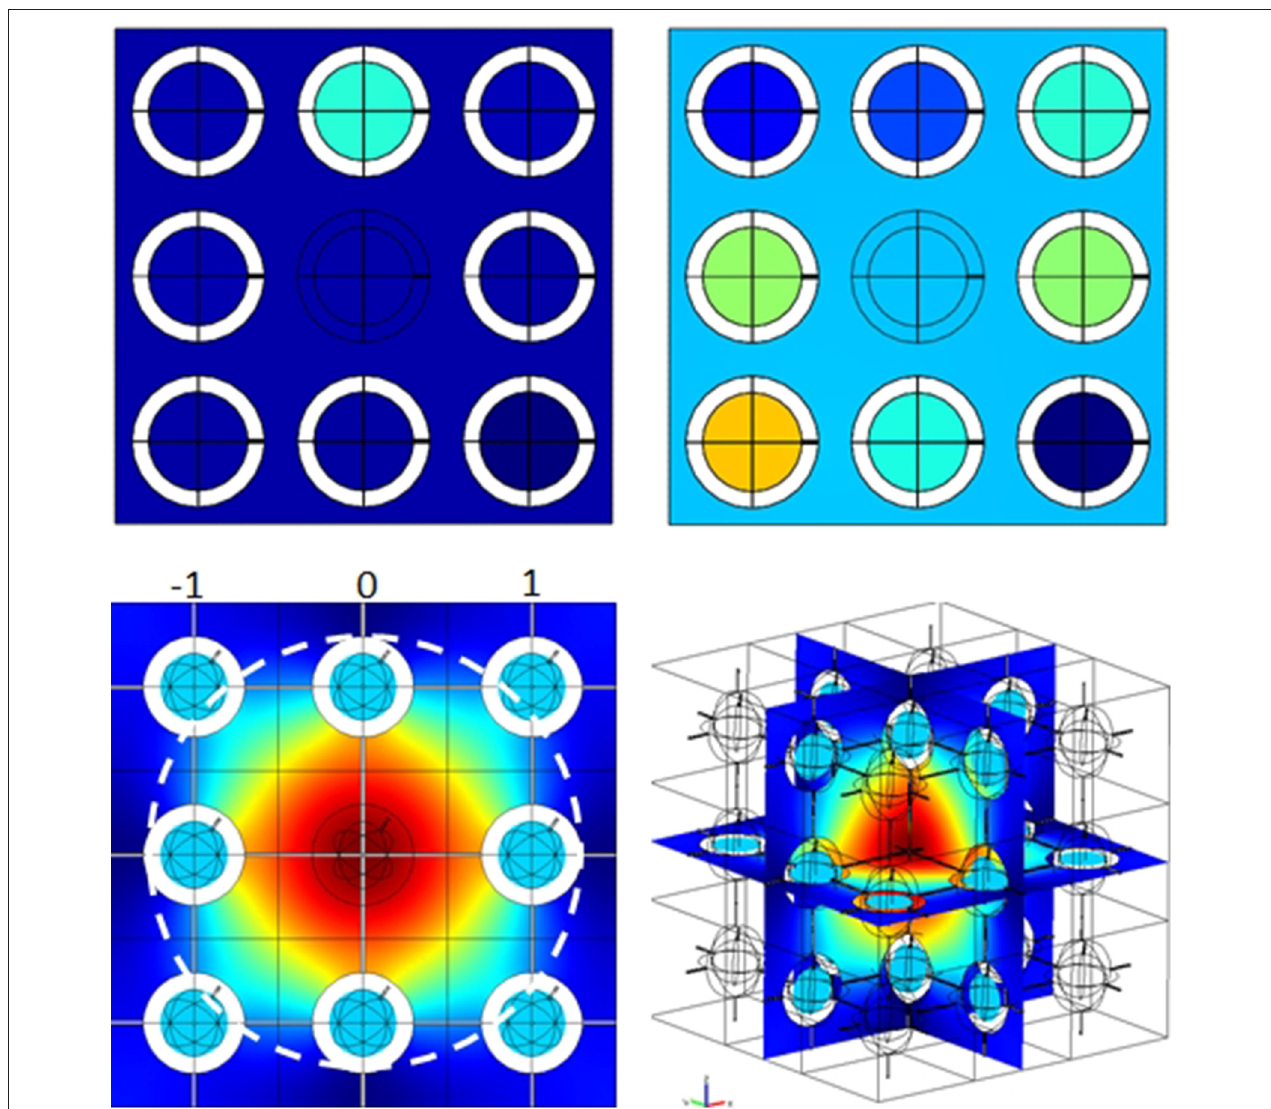
FIGURE 14 | Representative eigenfunctions for a macrocell of 26 resonators as in Figures 4 , 5 with a defect (air instead of resonator) in the middle. Upper panel: Eigenfunctions corresponding to an eigenfrequency ω ∗ 0 52.3545 rad.s − 1 in the ultra-low frequency stop band of Figure 4 . Lower panel: Eigenfunction = 559.2042 rad.s − 1 above the low frequency stop band of Figure 4 , which is approximated by the first root of (38) i.e., the corresponding to an eigenfrequency ω ∗ 1 = fundamental resonance of an effective spherical cavity (marked by dashed circle) of radius a 1.25 =